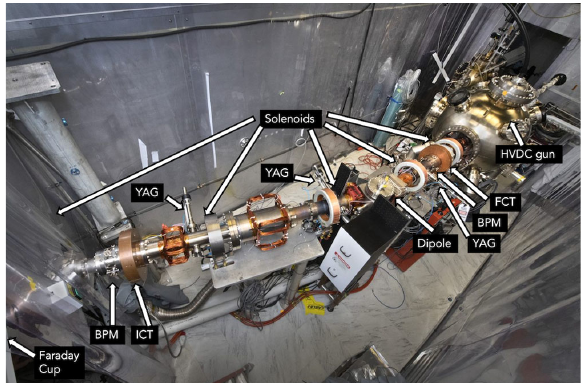
FIG. 7. The HVDC gun test beam line. All the diagnostics are labeled.